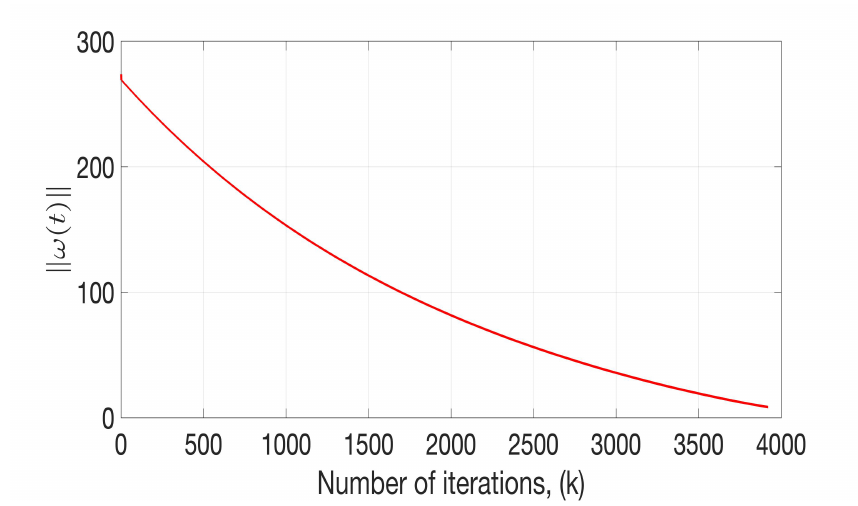
Figure 6. Recurrent evolution of the cost function defined by the Kiefer–Wolfowitz method.